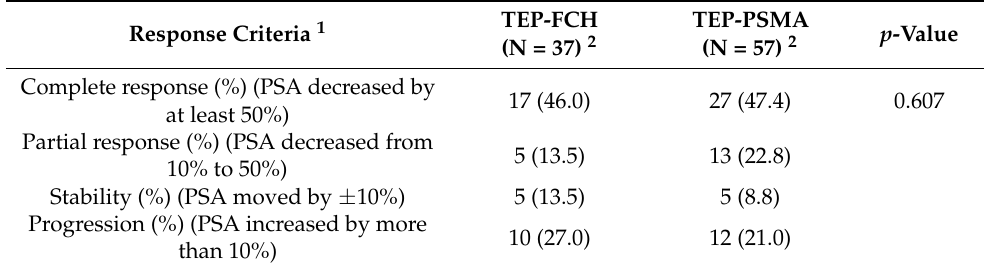
Table 4. PSA response at 3–6 months